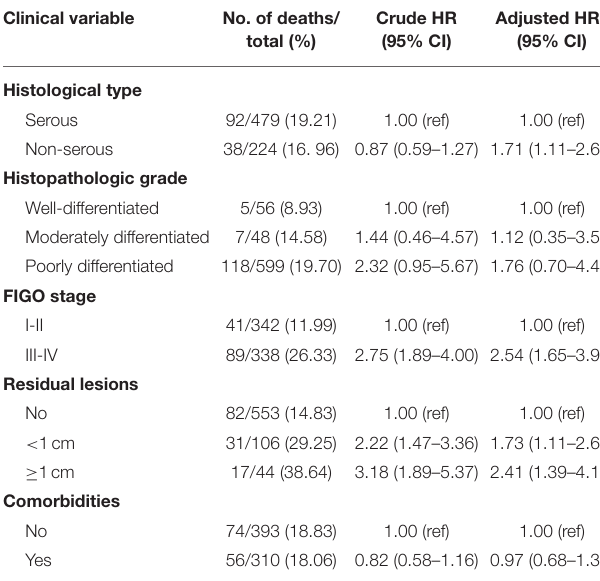
TABLE 5 | Clinical information and associations with all-cause mortality among OOPS participants. Clinical variable